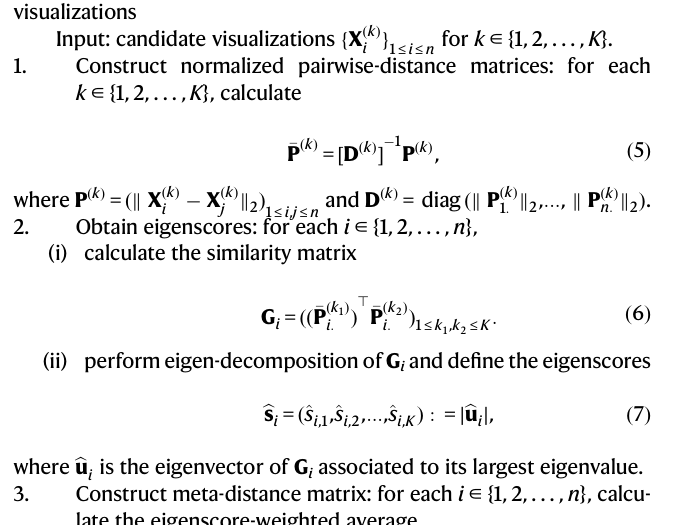
Algorithm 1 . Spectral assessment and combination of multiple data